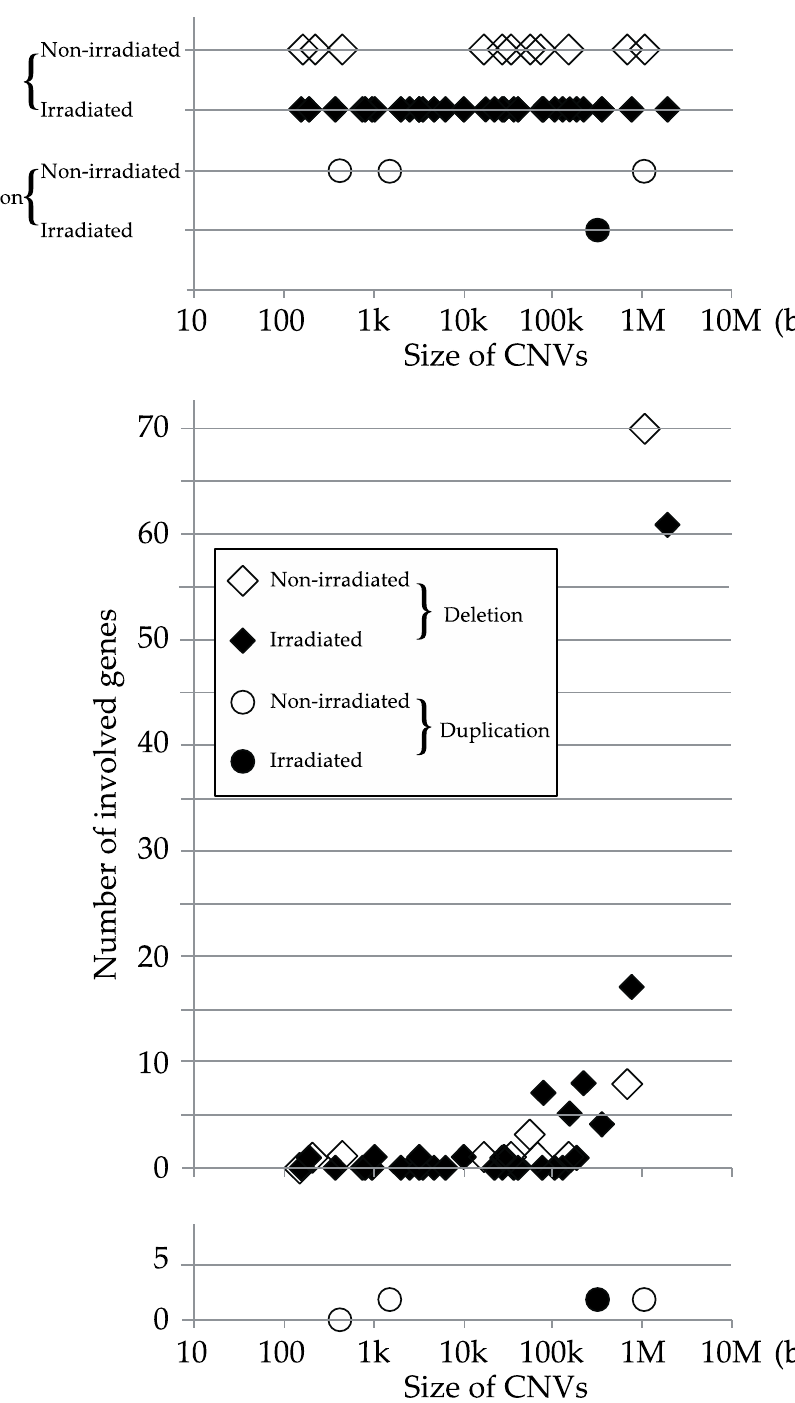
Figure 4. ( A ) Size of de novo CNVs. ( B ) Number of genes in the region of each de novo CNV plotted against the CNV size. Table 5. Comparison of the sizes of the deletions found in the F1 mice of non-irradiated and irradi- ated groups.